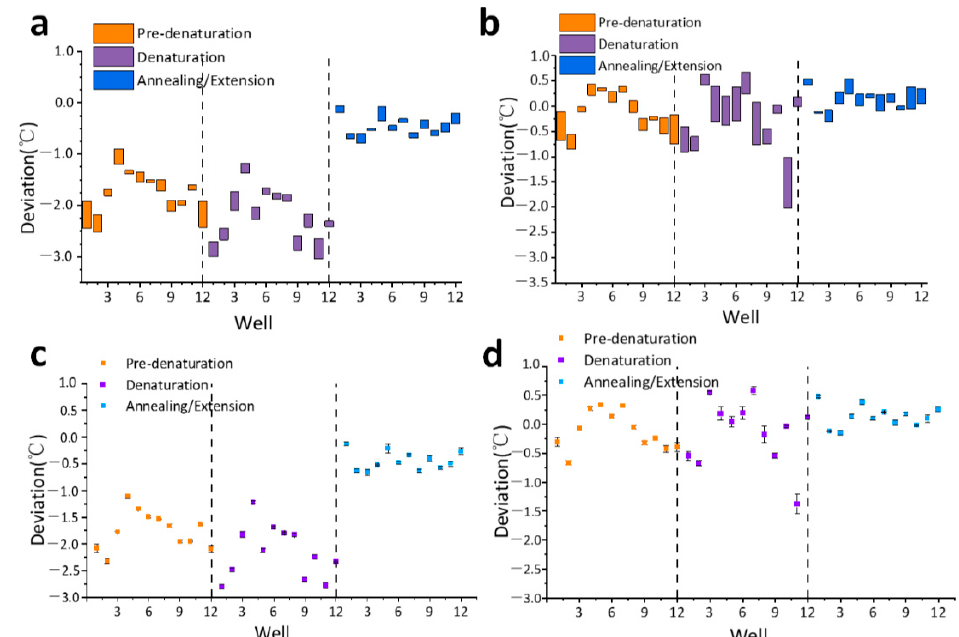
Figure 4. The actual temperature sampling of the reagent in the three steps of temperature cycle with 12 wells in the commercial PCR instrument. ( a ) The deviation range obtained from sampling in the initial temperature cycle; ( b ) The deviation range obtained from sampling in the upgraded temperature cycle; ( c ) The average value and standard deviation of sampling in the initial temperature cycle; ( d ) The average value and standard deviation of sampling in the upgraded temperature cycle.